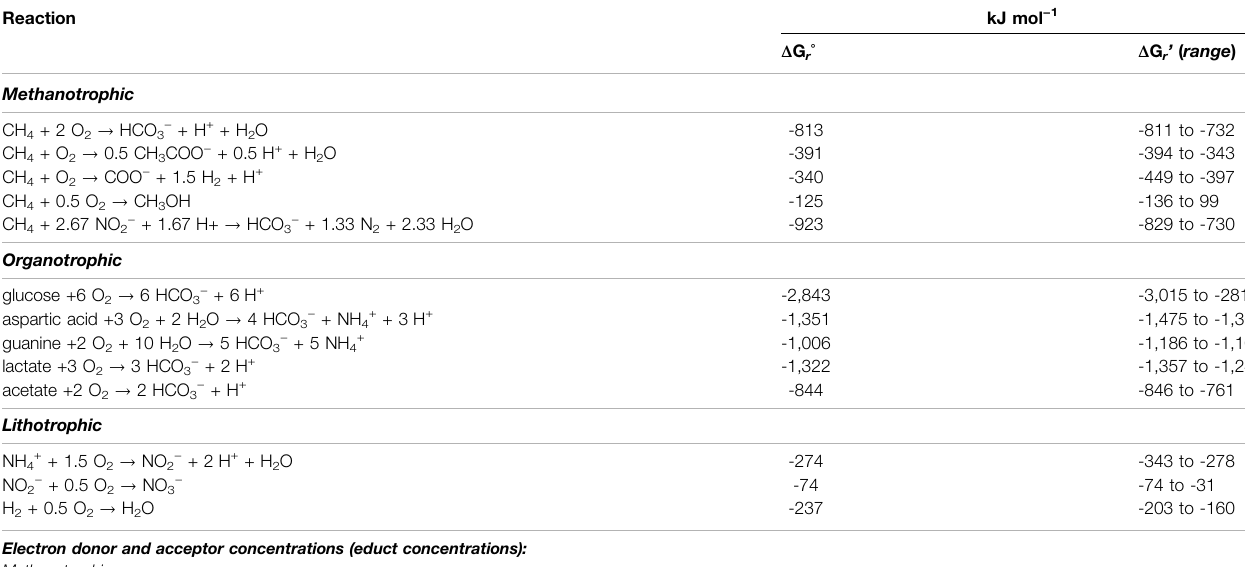
TABLE 5 | Gibbs energies of potential aerobic and denitrifying methanotrophic reactions, organotrophic reactions, and lithotrophic reactions. We include Gibbs energies under standard conditions ( Δ G r ° ), and for a range of environmentally relevant educt and product concentrations ( Δ G r ° (range), see footnote below table) assuming standard temperature, pressure, and pH (Note: the impact of in situ temperature, pressure, and pH on Gibbs energy yields is negligible within the range of calculated educt and product concentrations).